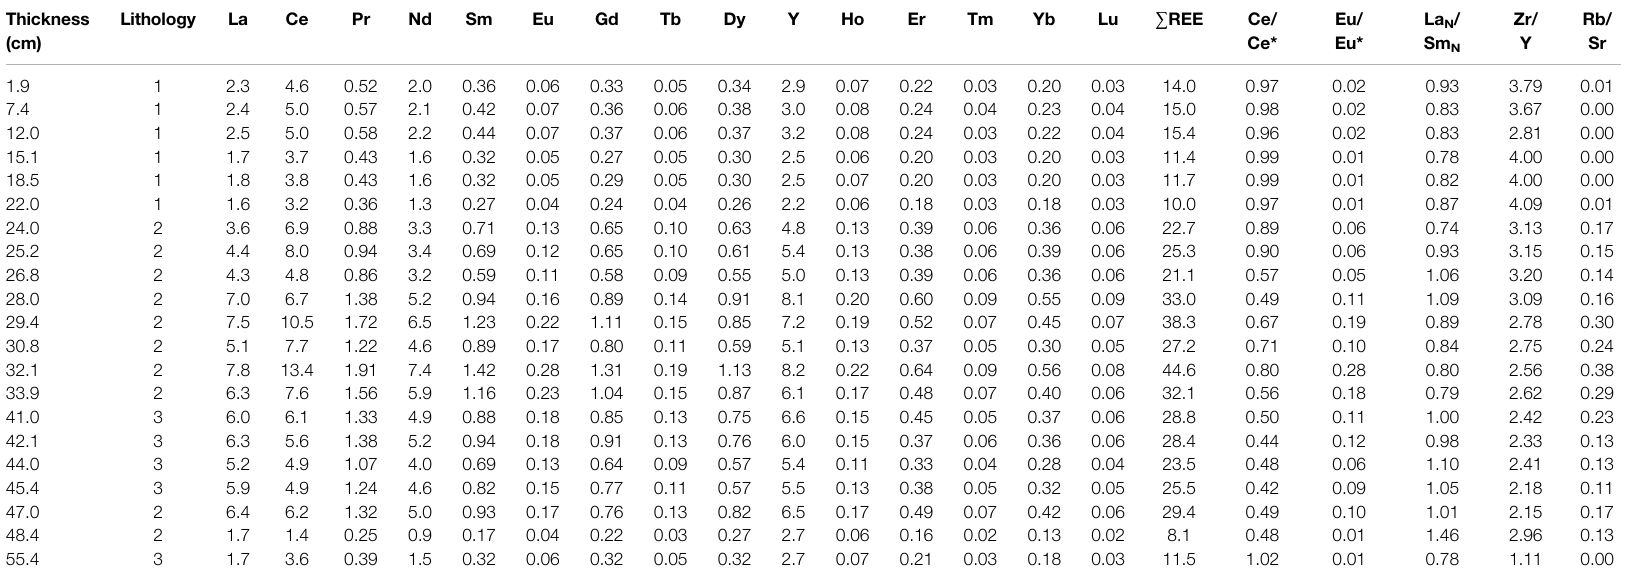
TABLE 3 | REE contents and representative element ratios in the upper and lower marl and shale layers, the Lengshuixi section. Thickness